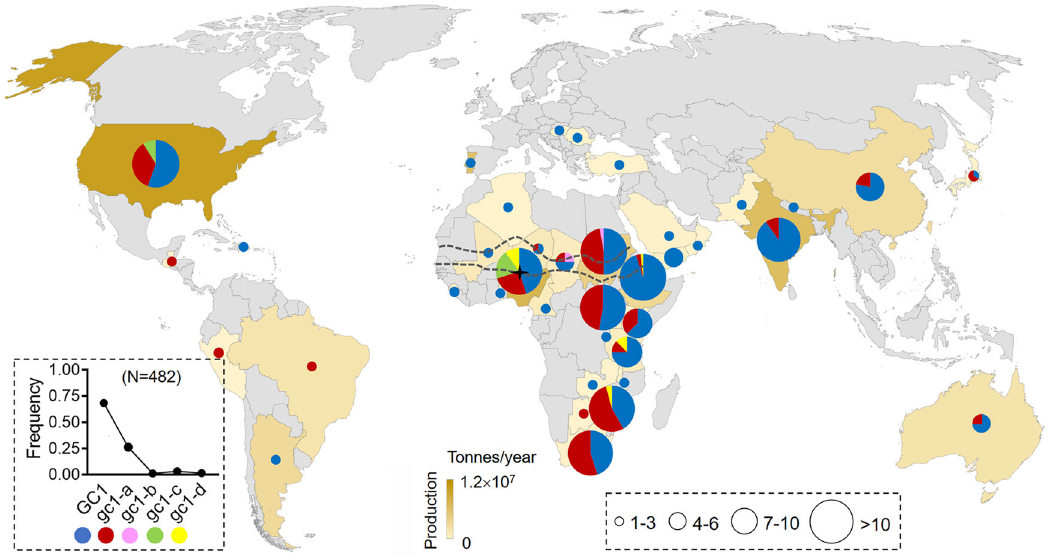
Fig. 6 Geographic distribution and selection of GC1 haplotypes. Geographic distribution of the wild type GC1 (blue color) and the other four mutated GC1 haplotypes in 38 countries worldwide (dark yellow). The pie chart indicates the frequency of haplotypes in each country. The black dot chart shows frequency of each haplotype among the total 482 sorghum accessions. GC1 was found in thirty-four countries while gc1-a occurred in nineteen countries. N number. Rare haplotypes gc1-b , gc1-c , and gc1-d were colored in pink, green and yellow. Countries with most of rare haplotypes were approximately localized to the Sahelian zone (gray dotted line). The black star shows Nigeria, which contains four GC1 haplotypes simultaneously. Circle size represents the number of sorghum accessions. The color depth of each country on the map indicates the average annual production of sorghum in recent 20 years. Source data are provided as a Source Data fi